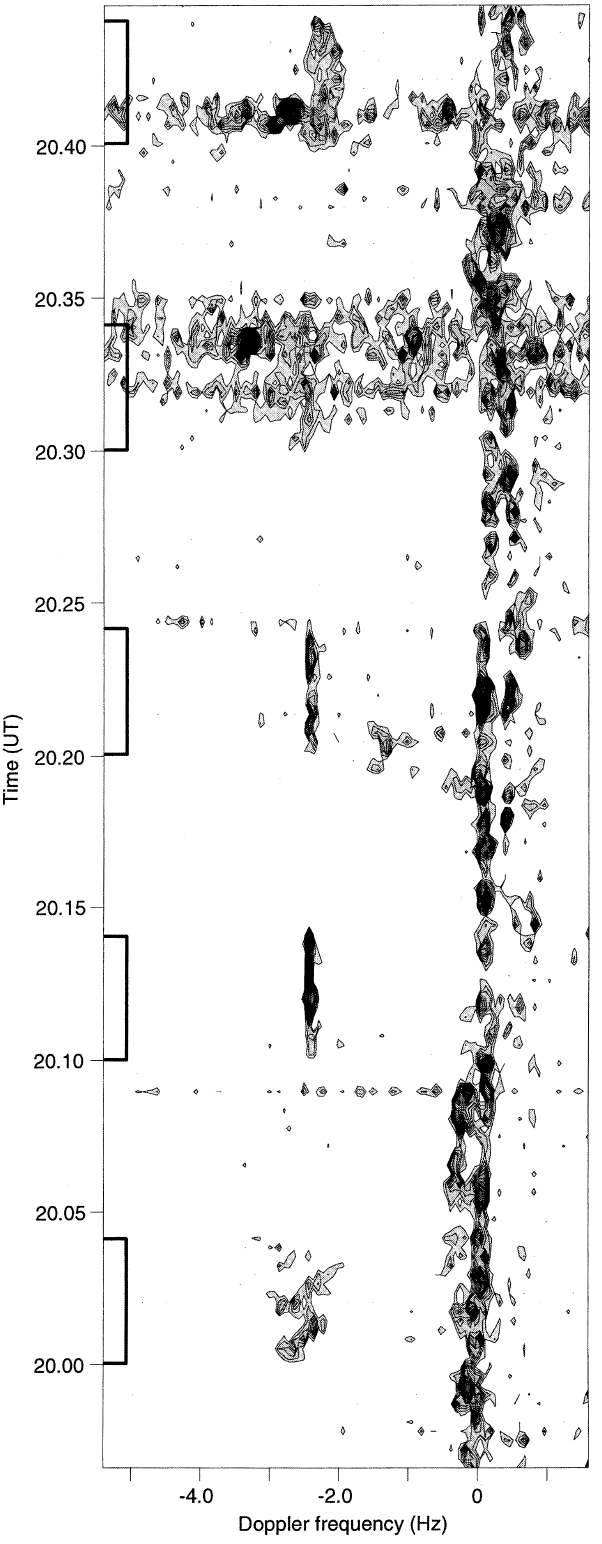
Fig. 2. The dynamic Doppler spectra (sonogram) of the HF distance diagnostic signals at operational frequency 12095 kHz on the London – Tromsø – St. Petersburg path in the course of the heating experiment on 17 February, 1996. The direct signals propagating from the transmitter to the receiver along a great circle path correspond to the 0 Hz Doppler frequency. Additional tracks on the negative part of Doppler sonogram shifted by about ) 2.5 Hz from that of the direct signals correspond to the field-aligned scattered signals. The intervals, when the Tromsø heating facility was turned on, are marked on the